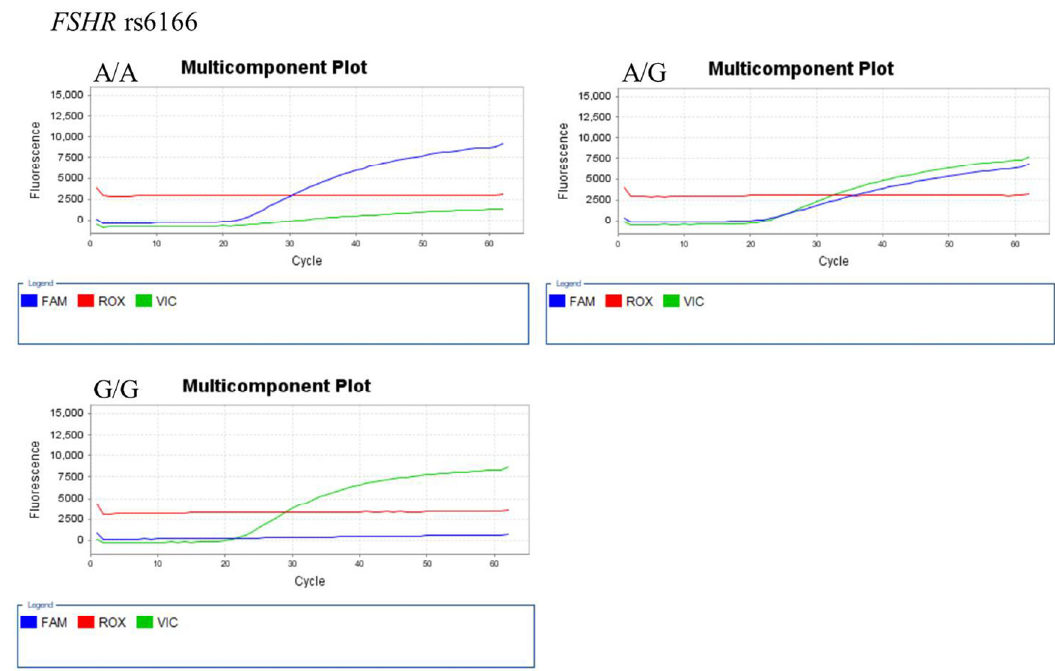
Figure 2. Representative TaqMan assay for FSHR (rs6166) genotyping. The FAM (blue) and VIC (green) fluorescence probes detect A and G alleles, respectively. The ROX (red) fluorescence probes is used for calibration.